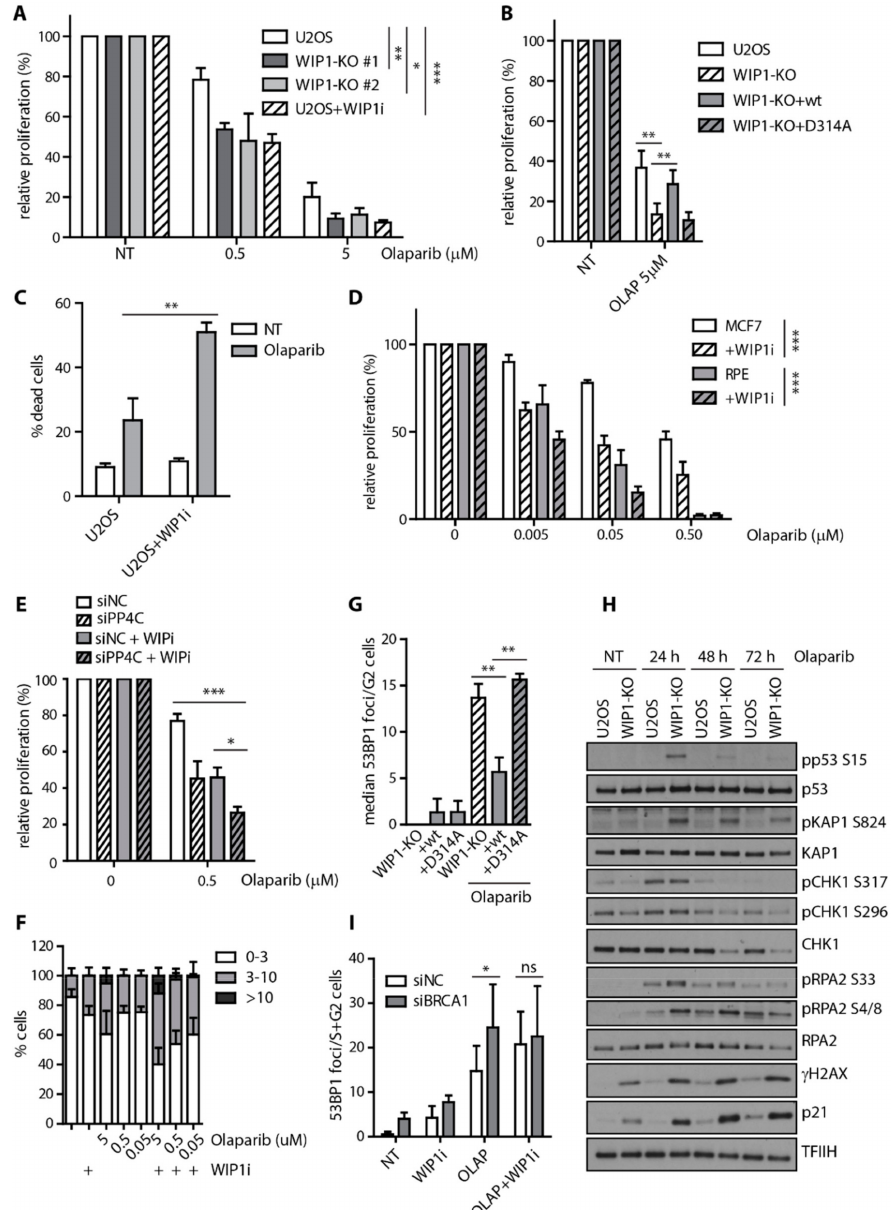
Figure 5. WIP1 deficient cells are more sensitive to PARP inhibition. ( A ) Cell survival of parental U2OS, two independent U2OS-WIP1-KO cell lines with or without combined treatment with WIP1i was evaluated 7 days after treatment with indicated doses of olaparib using resazurin viability assay. Plotted is mean +/ − SD, n ≥ 3. Statistical significance evaluated by two-way ANOVA. ( B ) Cell survival of parental U2OS, U2OS-WIP1-KO cells and cell lines complemented with wild-type or phosphatase-dead (D314A) mutant of WIP1 in response to 5 µ M olaparib as in A. Statistical significance evaluated by two-tailed t -test (n ≥